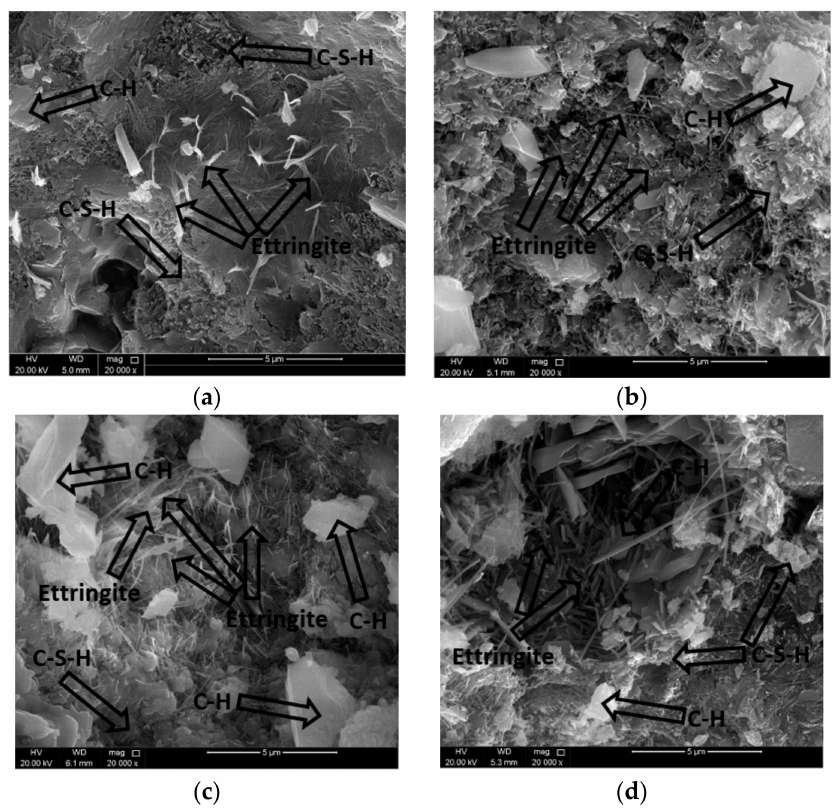
Figure 6. SEM images of the fractured surface of the strongest beam samples at 28 days: ( a ) Mix A; ( b ) Mix B; ( c ) Mix C; and ( d ) Mix